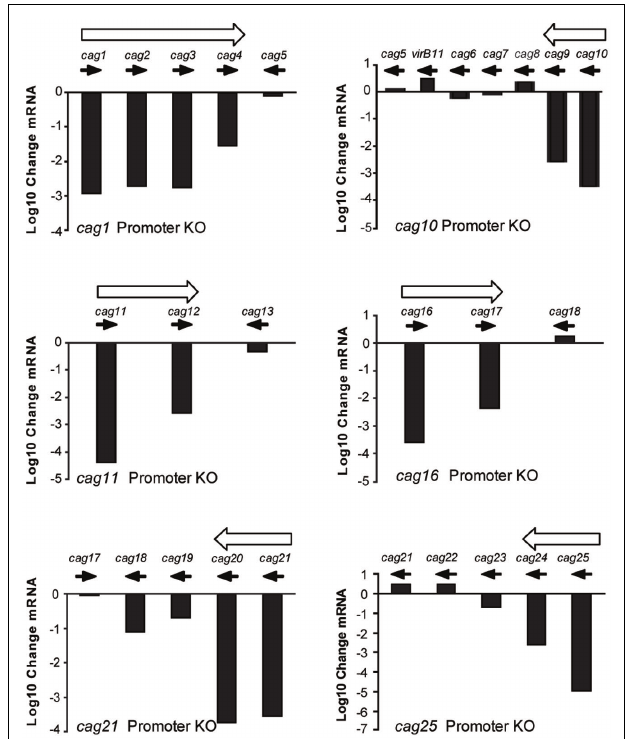
FIGURE 3 | Change in cag PAI gene expression (log10 change mRNA) between wild type H. pylori J166 and isogenic deletions of DNA upstream of the translational start codon in cag1 (416bp, top left), cag10 (498bp, top right), cag11 (498bp, middle left), cag16 (532bp, middle right), cag21 (615bp, bottom left), and cag25 (706bp, bottom right). Filled arrows indicate direction of transcription and open arrows indicate putative